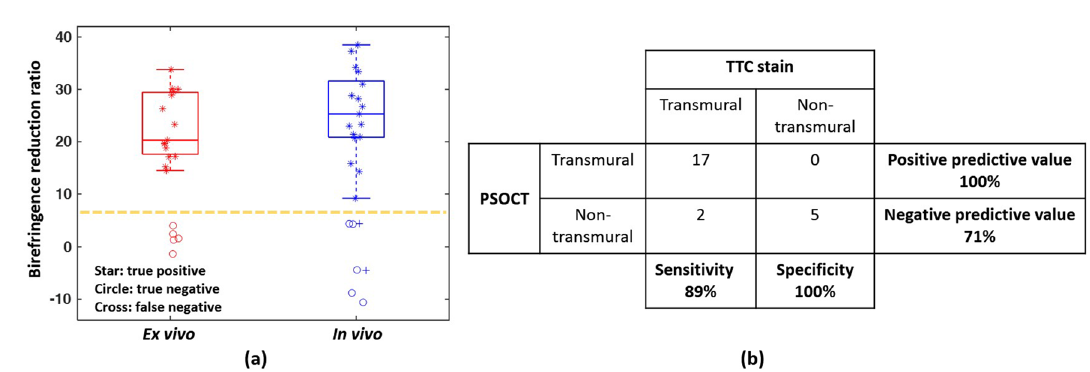
Figure 6. Summary of all analyzable data. ( a ) Birefringence reduction ratio comparison for all ex vivo and analyzable in vivo data; ( b ) confusion matrix for all analyzable in vivo